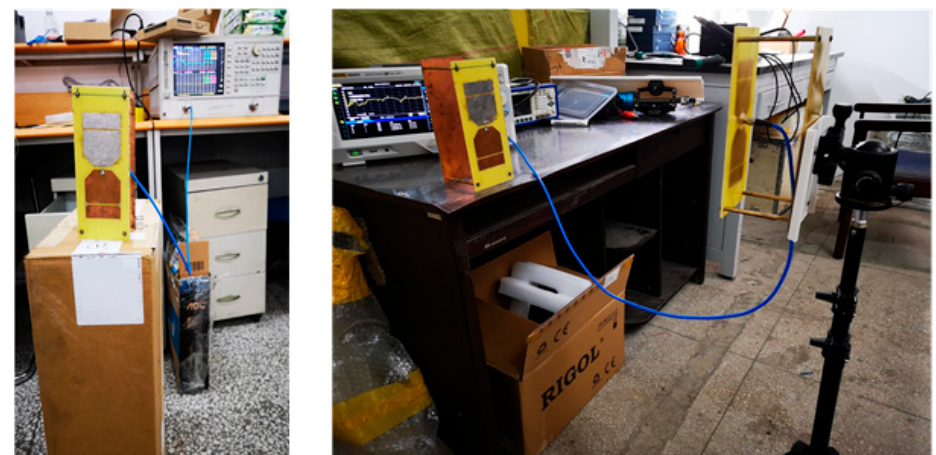
Figure 15. Two photos display the environment of measurement.